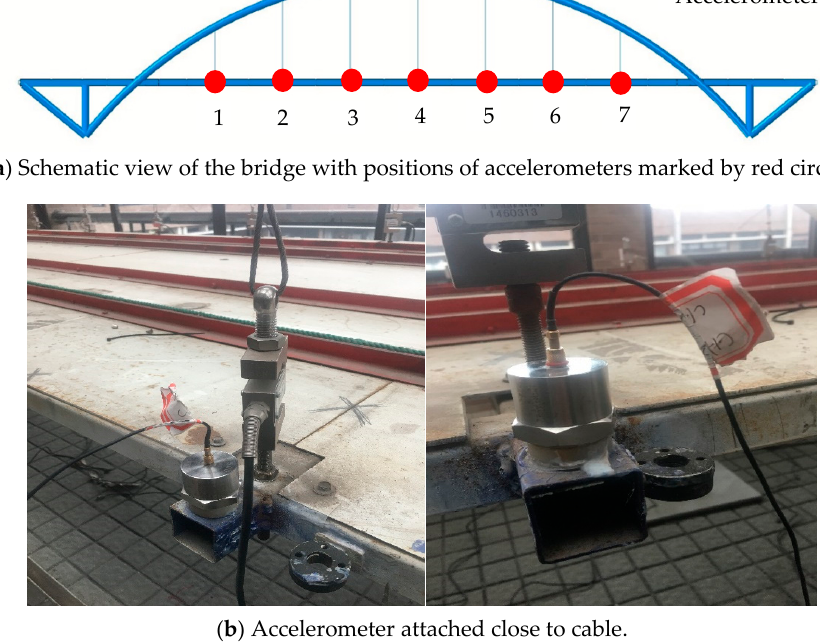
Figure 8. Side view of the model showing ( a ) locations of accelerometers installed on one side of the bridge and ( b ) accelerometers attached close to the cables.